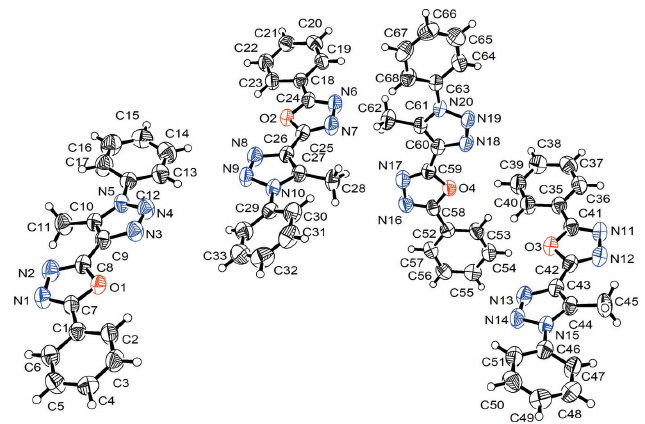
Figure 1 The molecular structure showing 50% probability.